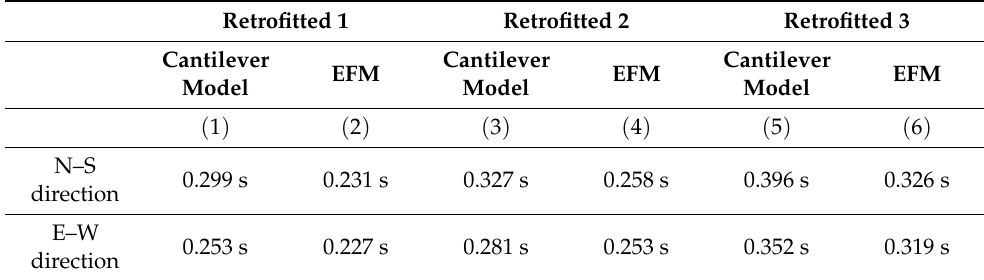
Table 3. Fundamental periods for the retrofitted structure.